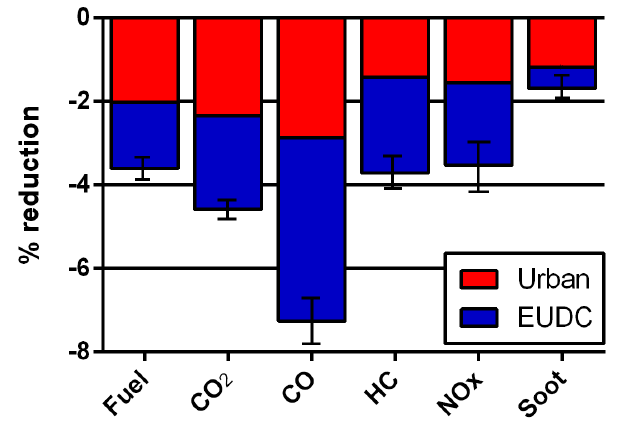
Figure 15. Fuel consumption and emission reduction due to the WHR-to-oil breakdown in urban (ECE) and extra-urban (EUDC) driving parts during a whole NEDC. Error bands are also reported.